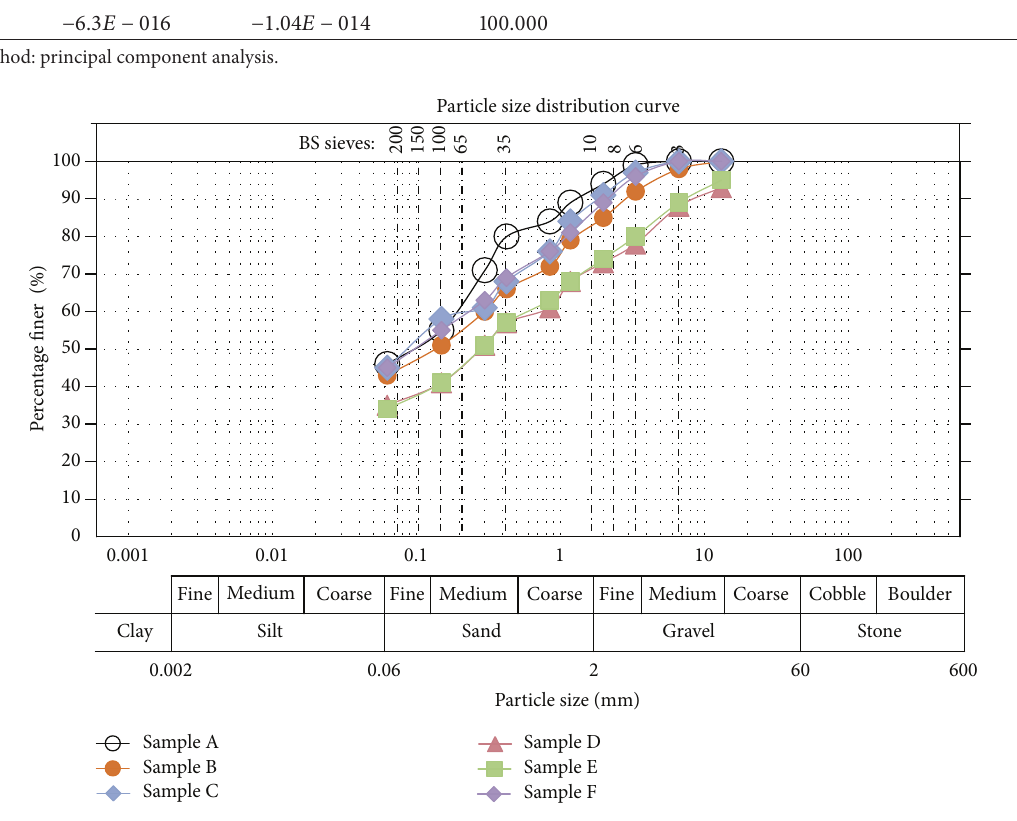
Figure 1: Result of particle size distribution analysis.